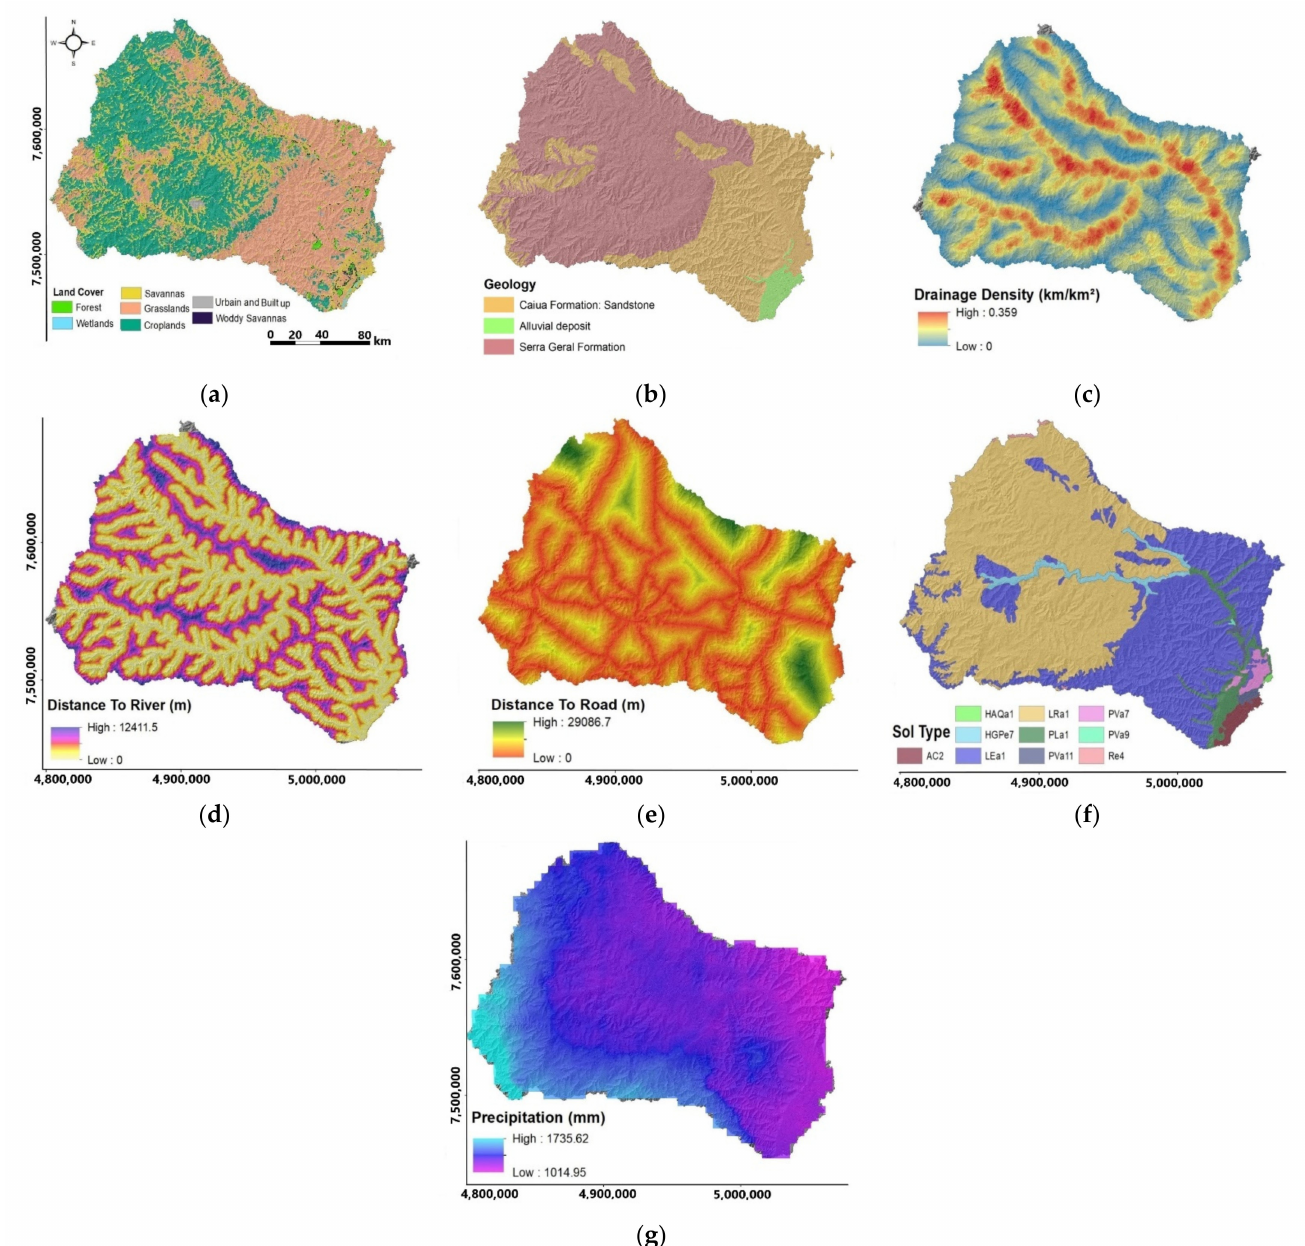
Figure 4. Selected parameters: ( a ) land cover, ( b ) lithology, ( c ) drainage density, ( d ) dis- tance to river, ( e ) distance to road, ( f ) soil type, and ( g ) precipitation. Spatial references SIR- GAS_2000_Brazil_Polyconic in